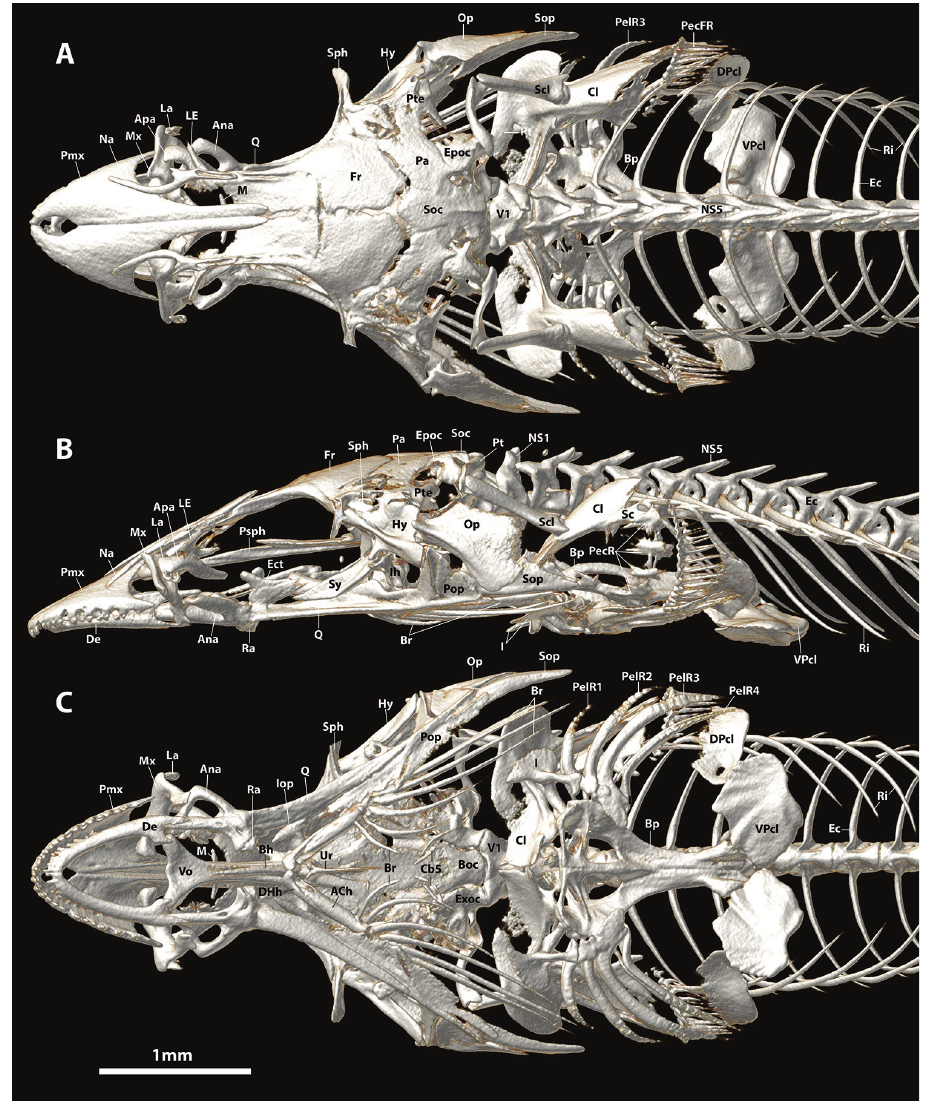
Figure 16. CT scanned anterior skeleton of Aspasmichthys ciconiae , TCWC 16461.02, 26.0 mm SL. A Dorsal view B Lateral view (left side) C Ventral view. Abbreviations: ACh, anterior ceratohyal; Ana, anguloarticular; Apa, autopalatine; Boc, basioccipital; Bp, basipterygium; Br, branchiostegal rays; Cb5, ceratobranchial 5; Cl, cleithrum; DHh, dorsal hypohyal; DPcl, dorsal postcleithrum; Ec, epicentral; Ect, ectopterygoid; Epoc, epiotic; Exoc, exoccipital; Fr, frontal; Hy, hyomandibular; I, pelvic-fin spine; Iop, interopercle; La, lachrymal; LE, lateral ethmoid; M, mesethmoid; Na, nasal; NS1, 5, neural spine of vertebral centrum 1, 5; Op, opercle; Pa, parietal; PecR, pectoral radial; PecFR, pectoral-fin ray; PelFR1-4, pelvic-fin ray 1–4; Pop, preopercle; Pro, prootic; Psph, parasphenoid; Pt, posttemporal; Pte, pterotic; Q, quadrate; Ra, retroarticular; Ri, rib; Sc, scapula; Scl, supracleithrum; Soc, supraoccipital; Sop, subopercle; Sph, sphenotic; Ur, urohyal; V1, vertebral centrum 1; Vo, vomer; VPcl, ventral